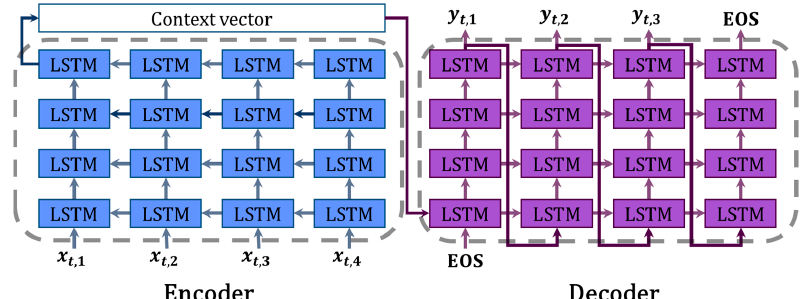
Figure 4. Seq2seq LSTM structure.